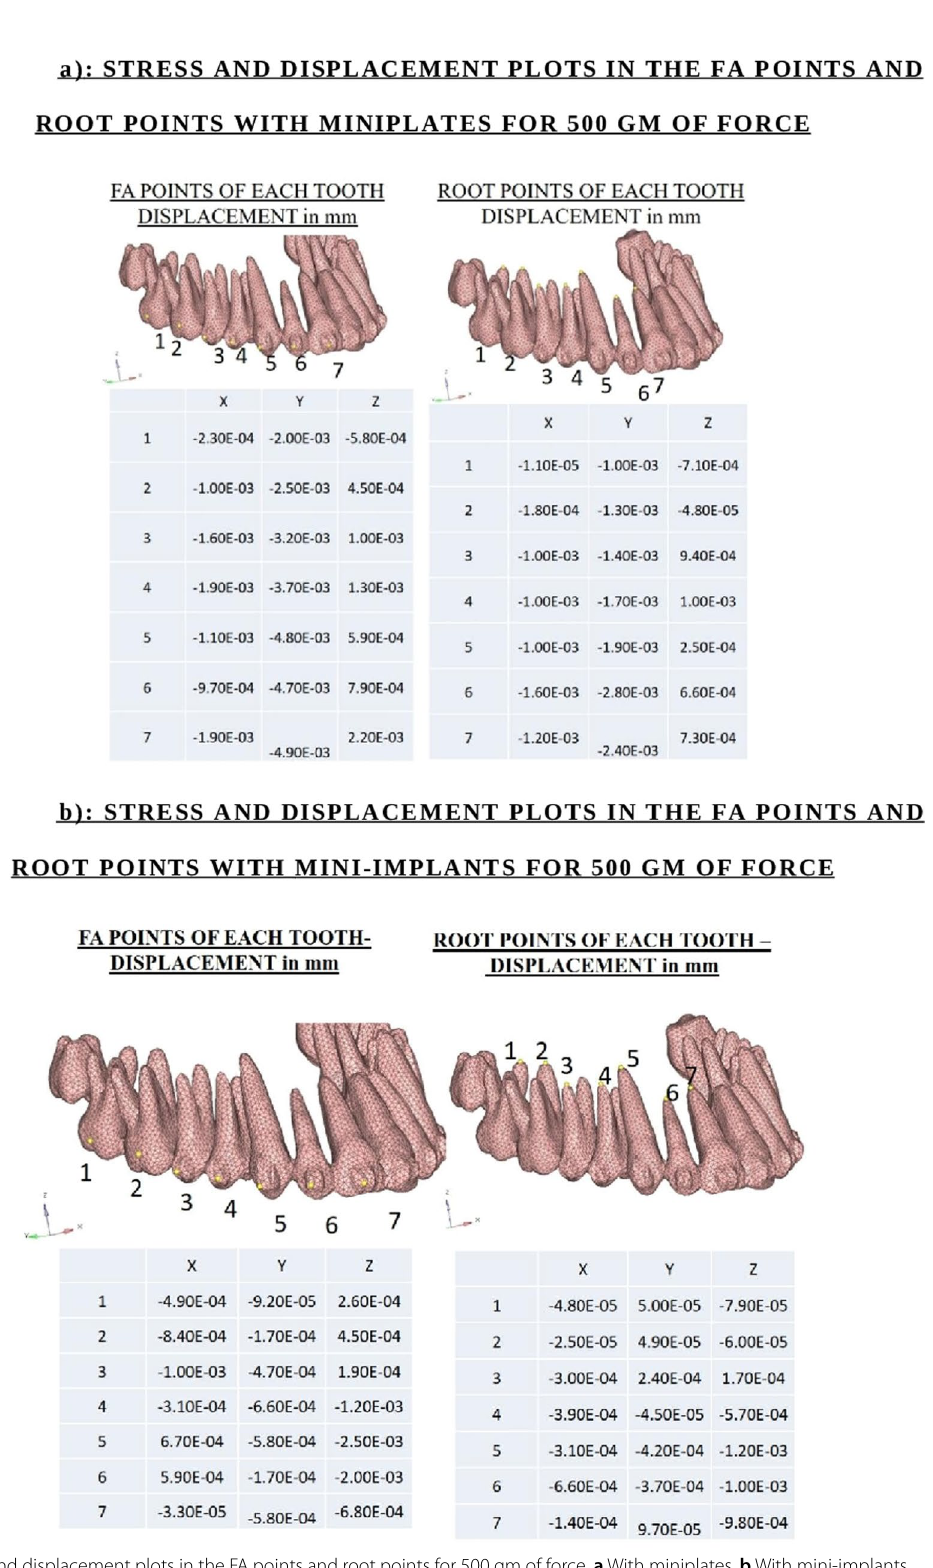
Fig. 5 Stress and displacement plots in the FA points and root points for 500 gm of force. a With miniplates. b With